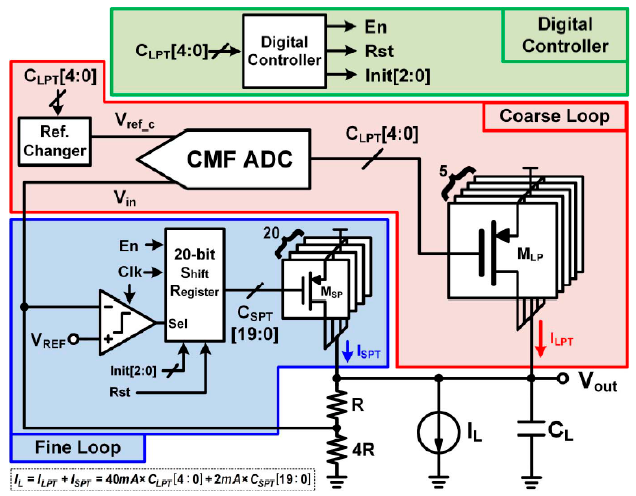
Figure 27. Coarse–Fine Dual Loop-Based DLDO [54].